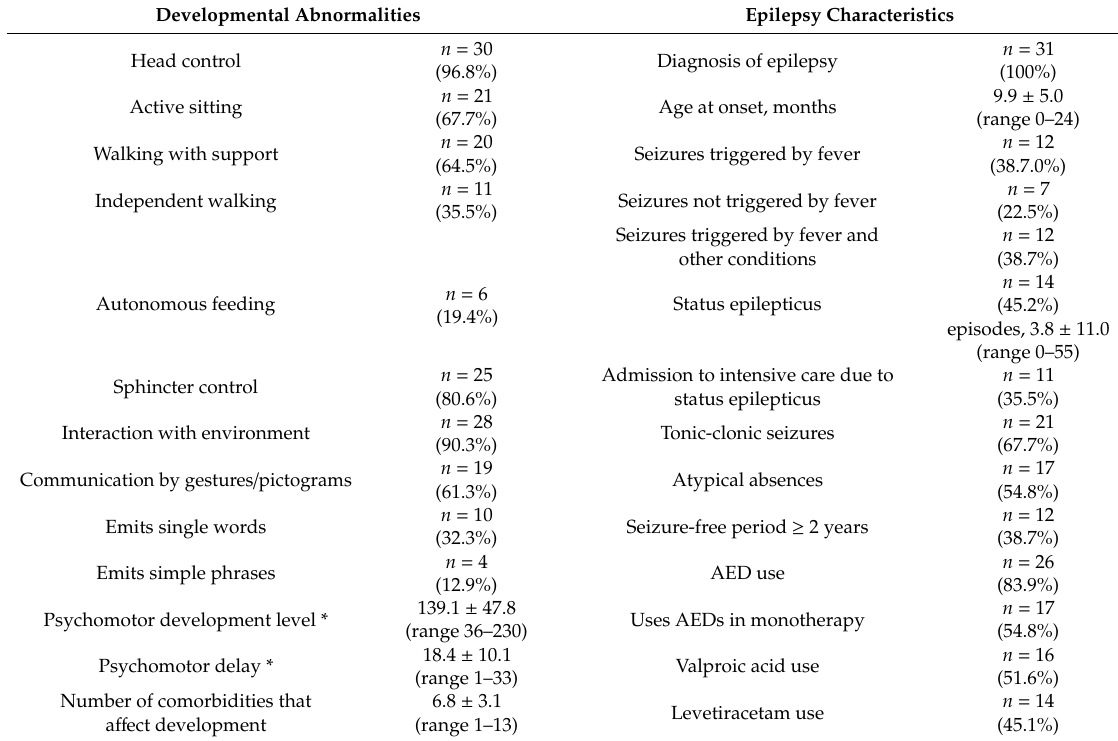
Table 2. Developmental abnormalities and epilepsy characteristics of study-group patients with Wolf-Hirschhorn syndrome ( n = 31).